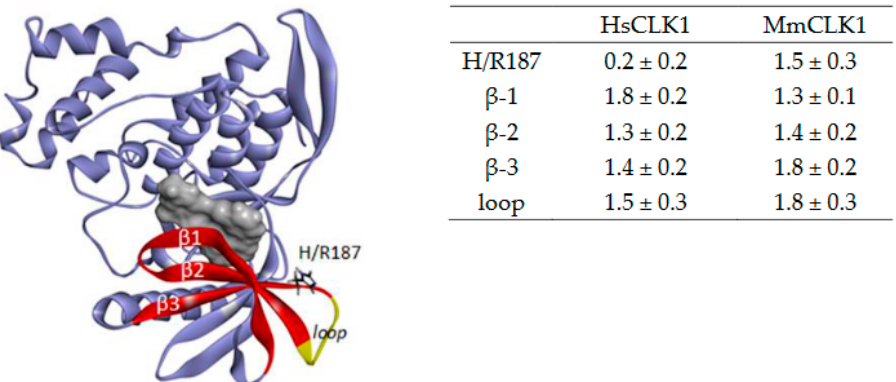
Figure 5. RMSD calculation (in Å) of H/R187 environment during 1 µ s molecular dynamics of Apo human and mouse CLK1. On the top, cartoon representation of CLK1 shows the active site (grey surface) and analyzed secondary structures.